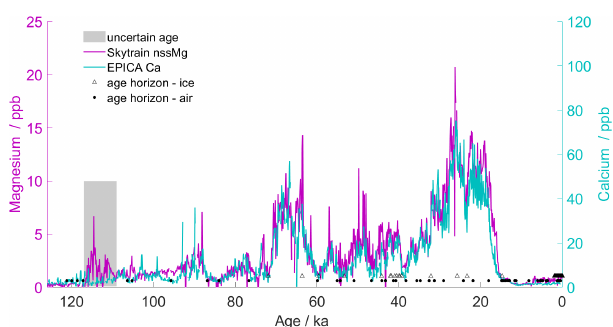
Figure 7. nssMg at Skytrain shown on its age scale after synchroni- sation (purple). nssCa from EDML (cyan) (Fischer et al., 2007). Tie points used in this paper are shown (circles are gas age, triangles are ice age ties). The grey shaded area represents the ice (605–617m) with unreliable ages due to flow disturbance (see Sect.